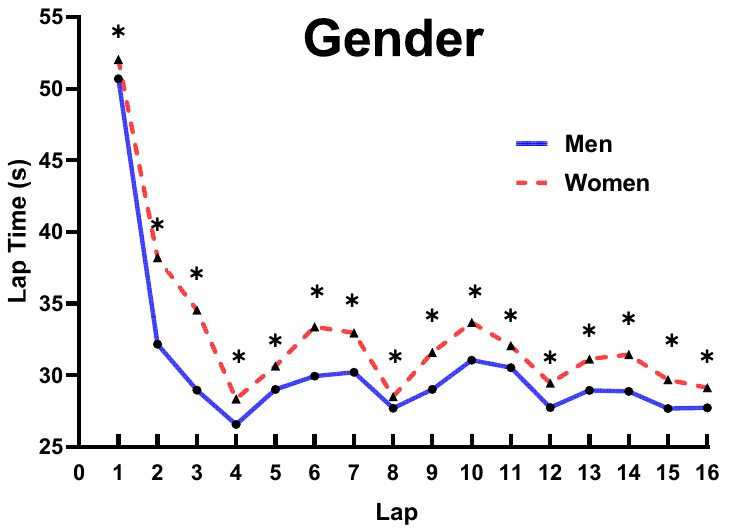
Figure 2. Comparison on lap time spent for G. Note: * marked values were significant when p ≤